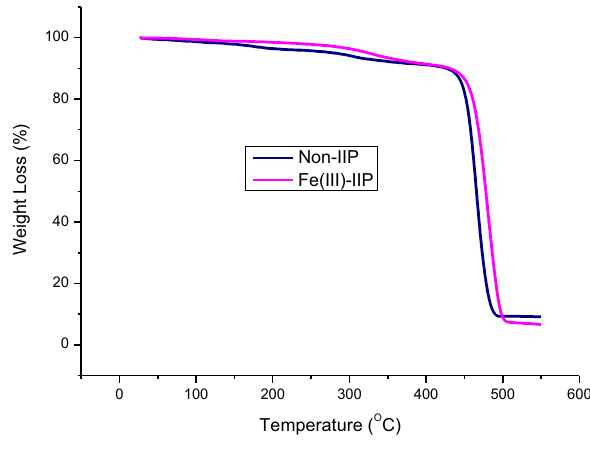
Fig. 8 Thermogravimetric analysis of a non-ion imprinting polymer and b Fe(III)-IIP